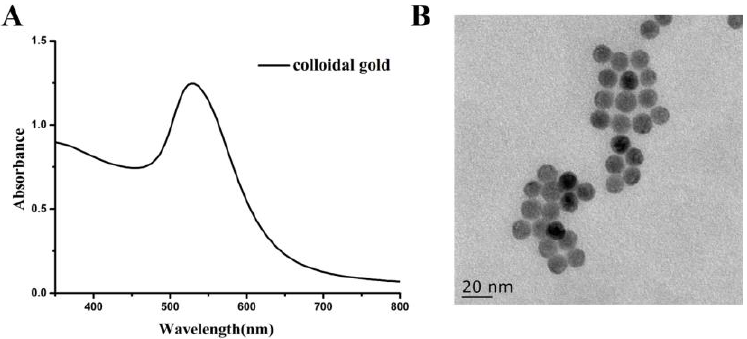
Figure 9. The characterization of colloidal gold: ( A ) UV-vis spectrum and ( B )